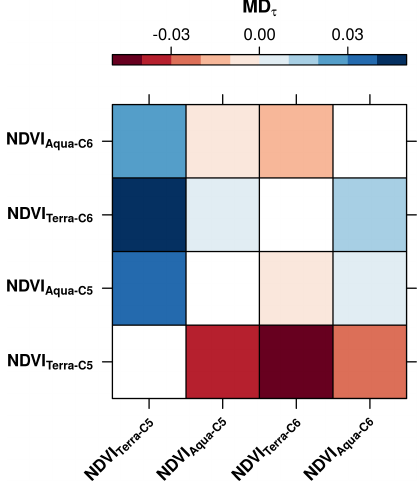
Figure 5. MD τ calculated from “conclusive” values of τ ( p < 0.001) for each pair of MODIS NDVI